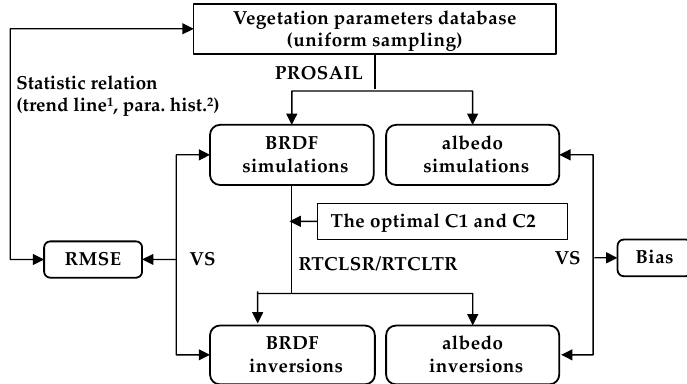
Figure 1. Flowchart of model comparison between the kernel-driven model and PROSAIL model.